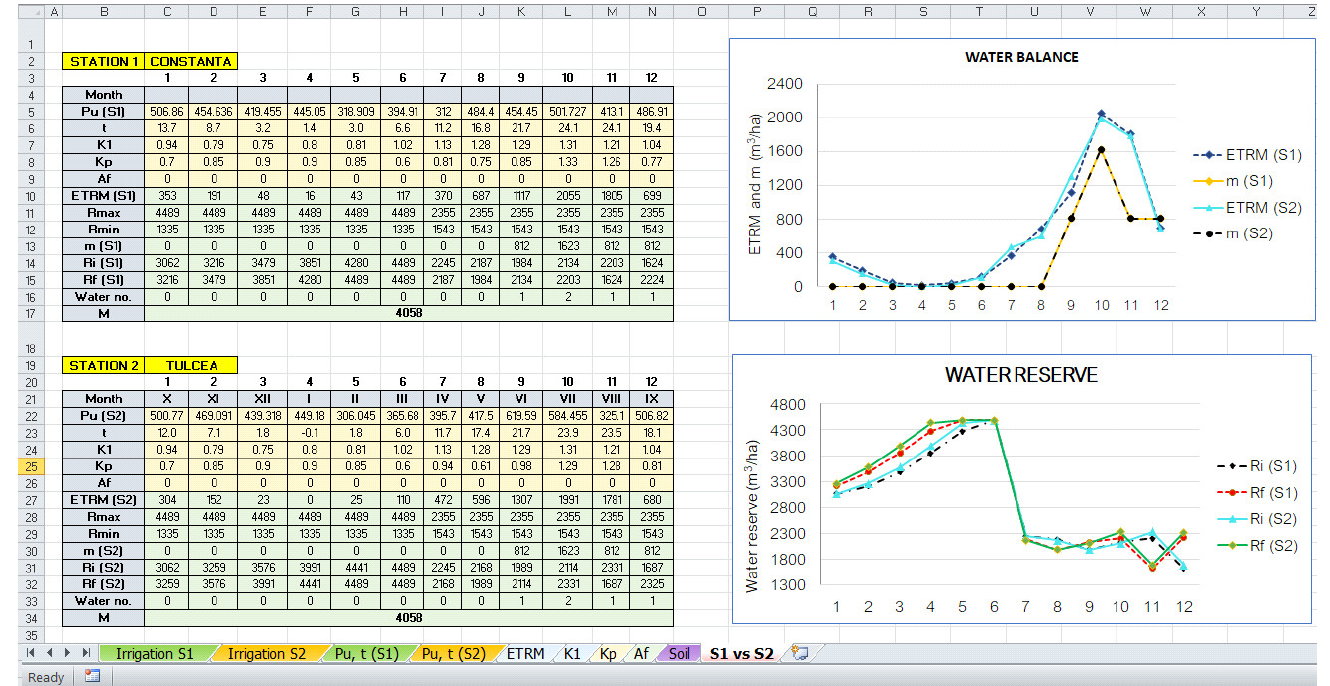
Figure 13. Computation results for TL.